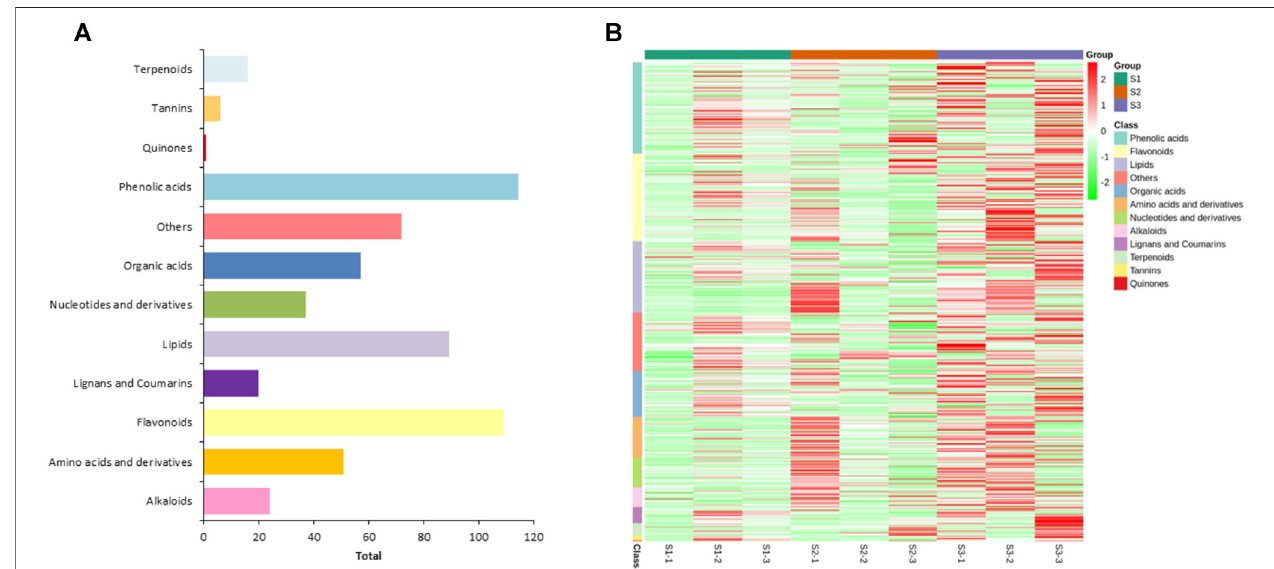
FIGURE 1 | Classi fi cation and abundance of the metabolites at three developmental stages of M. ternifolia nutshell. (A) The classi fi cation results of different metabolites (B) The abundance level of different metabolites.